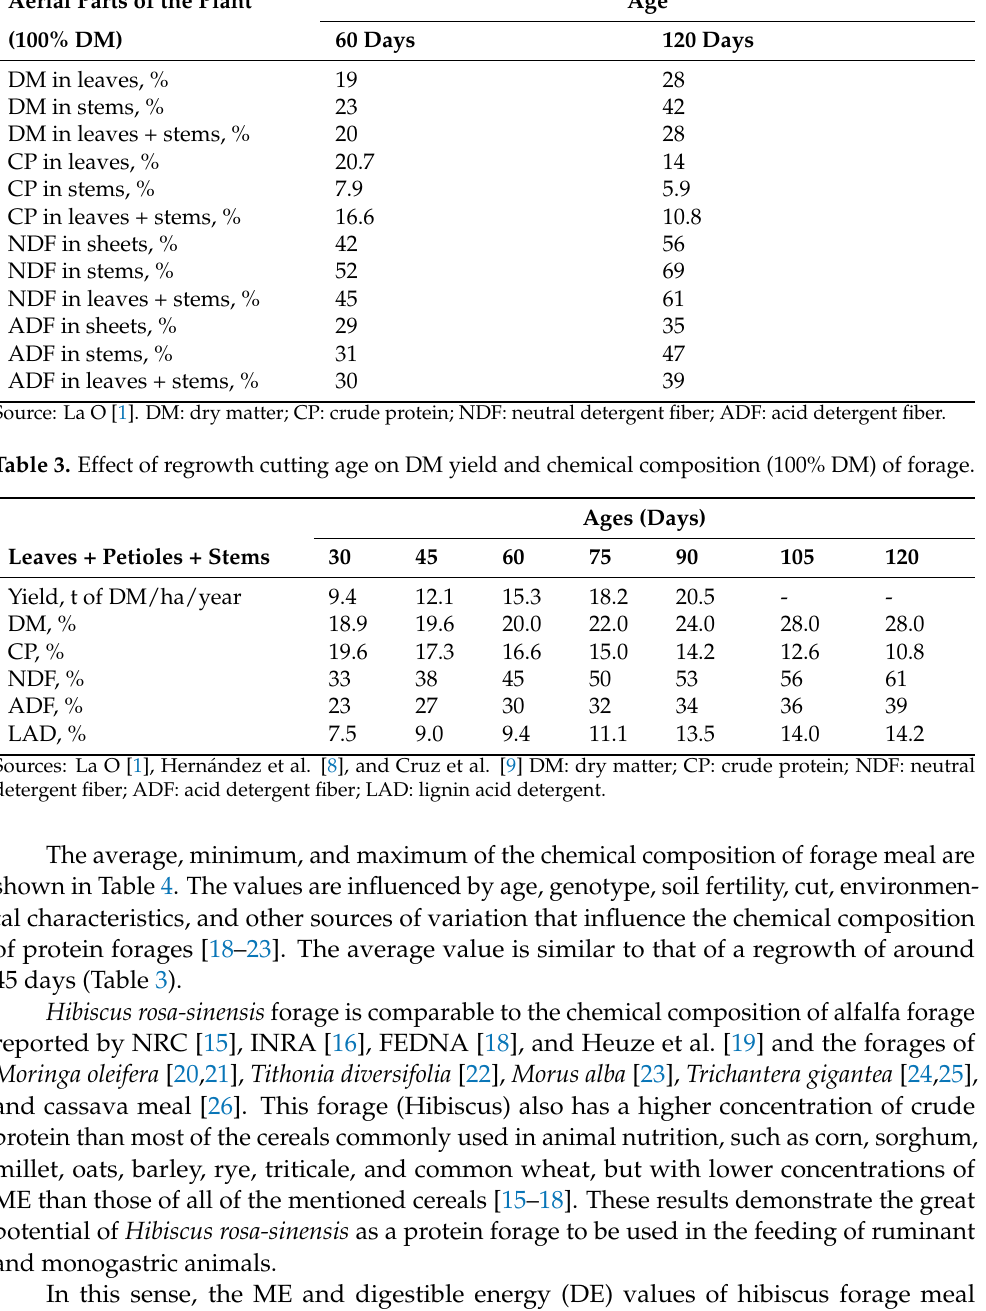
Table 2. Chemical composition of the aerial parts of Hibiscus rosa-sinensis cut at two ages. Aerial Parts of the Plant